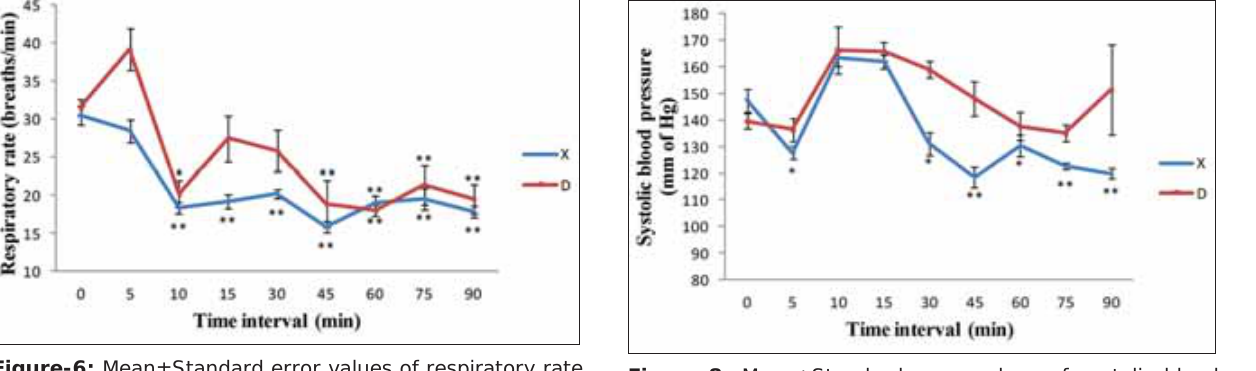
Figure-8: Mean±Standard error values of systolic blood pressure in animals of different groups. *Significantly different from the base value (p<0.05). **Significantly different from the base value (p<0.01).